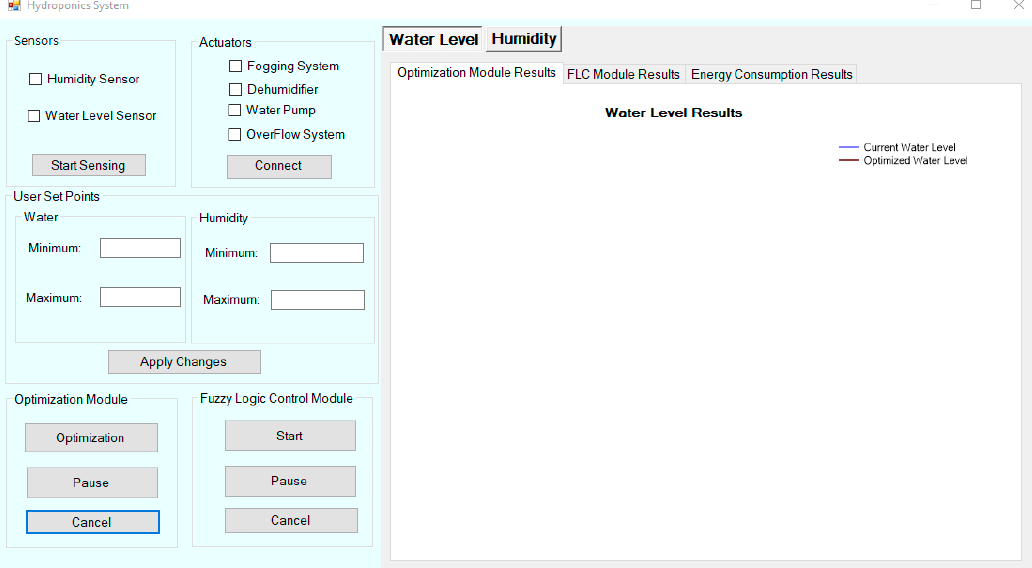
Table 5. Specification of implementation environment of general-purpose PC.